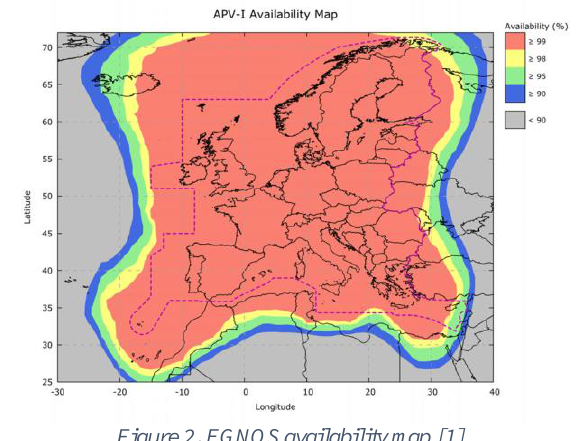
Figure 2. EGNOS availability map [1]